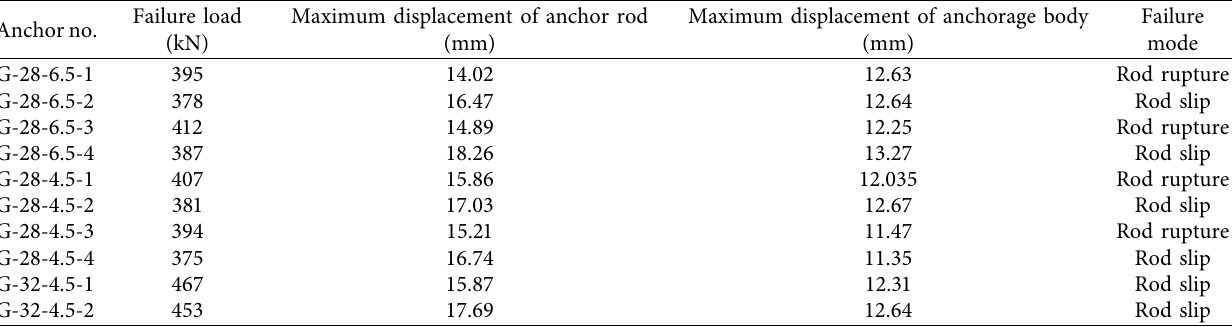
Figure 9: Photos of the failure modes of the experimental anchors: (a) rod slip failure and (b) rupture of the anchor rod. Table 2: Experimental results of the GFRP antifloating anchors.